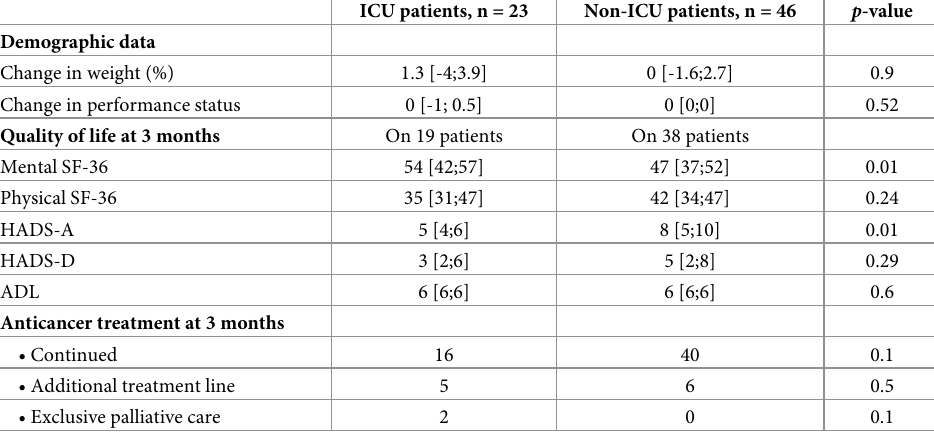
Table 3. Patient QoL and anticancer treatments at 3